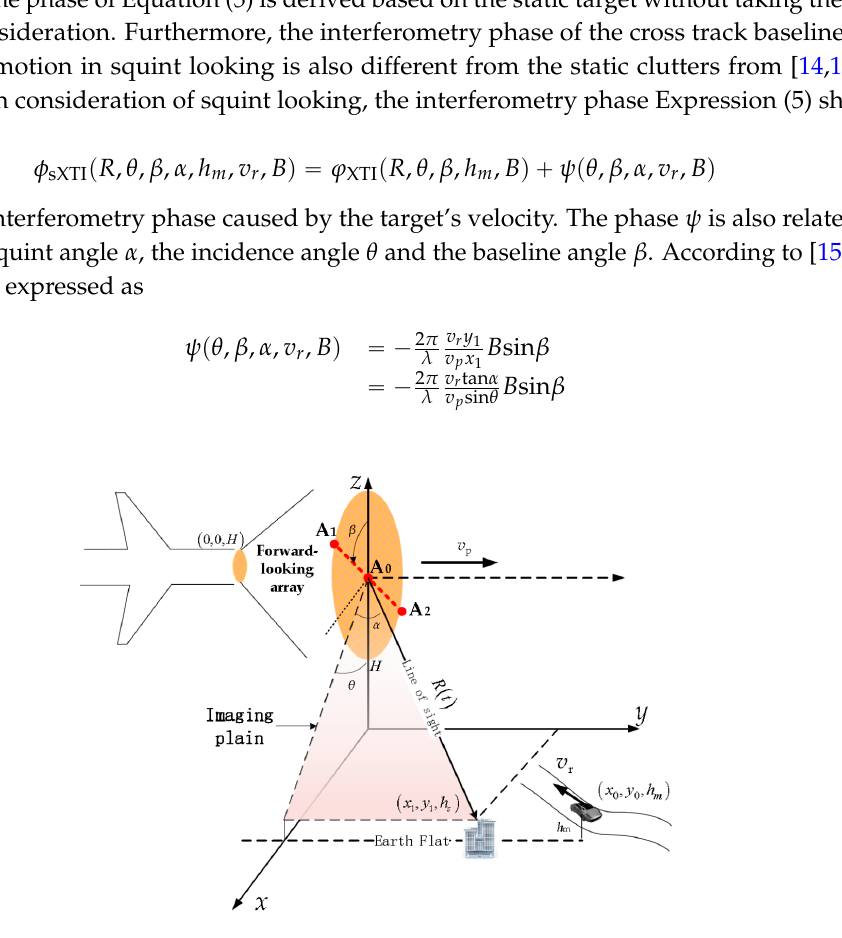
Figure 2. Airborne squint looking XTI-SAR system.